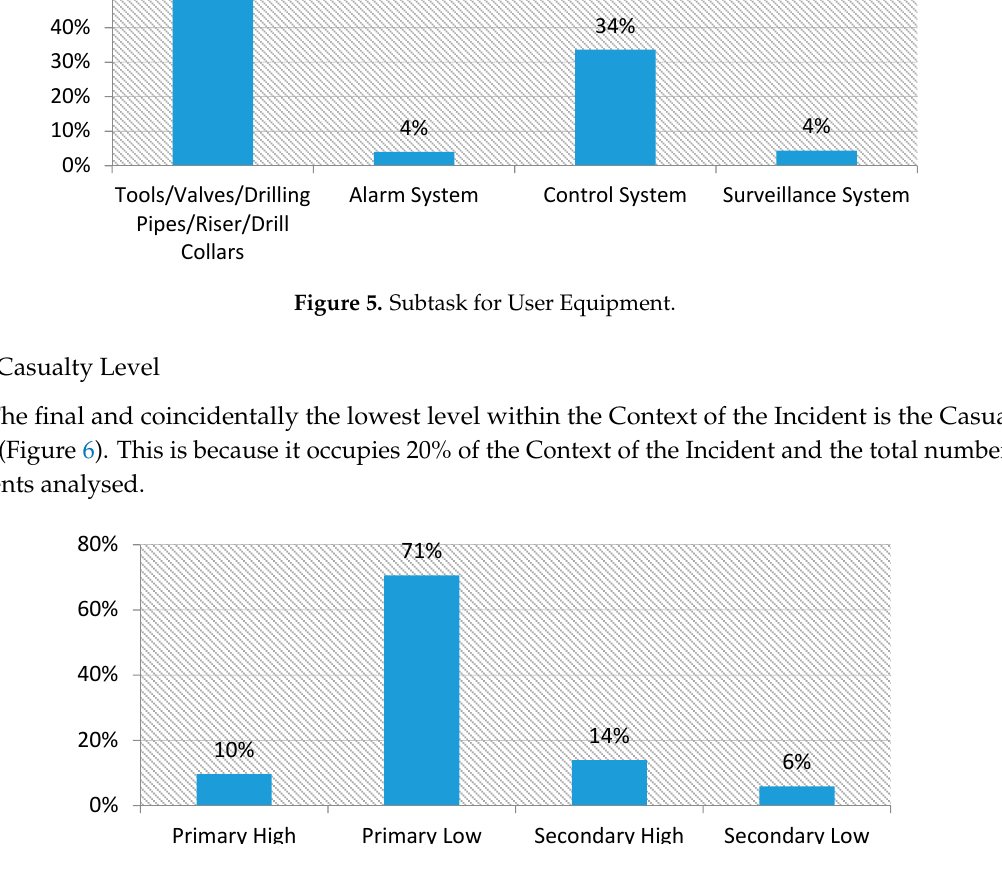
Table 1 above, the operator context was analysed under three headings: External Error Mode (EEM), Cognitive Domain divided into Internal Error Mode (IEM) and Psychological Error Mechanism (PEM)) and Performance Shaping Factors (PSF). A total of 1326 errors were coded for the Operator’s